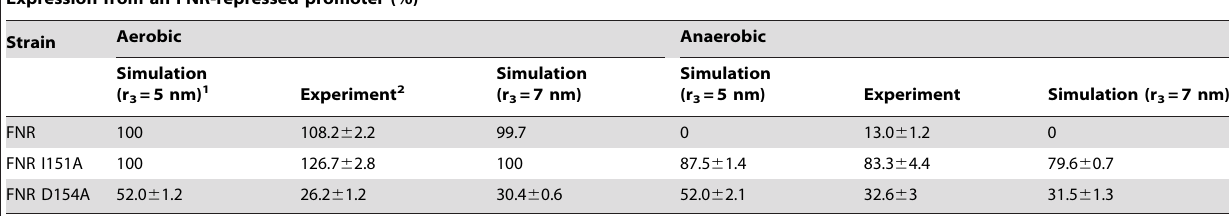
Expression from an FNR-repressed promoter